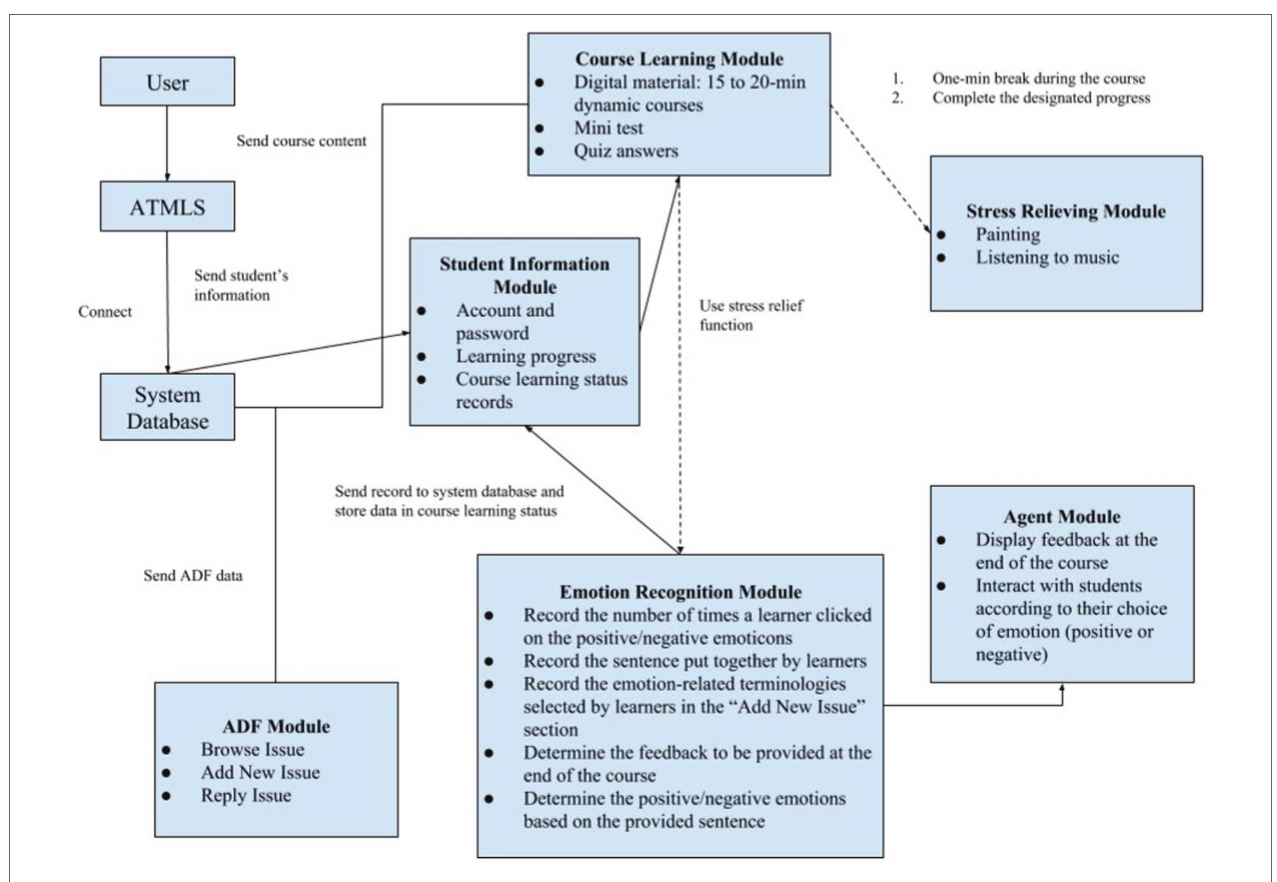
FIGURE 1 | Design of the